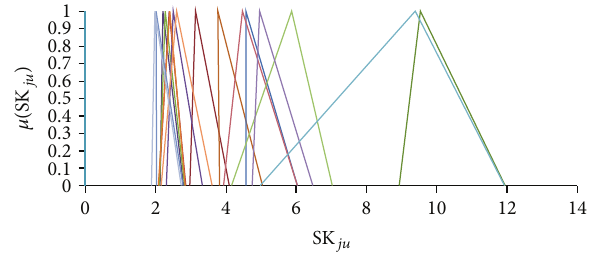
Figure 7: The fuzzy slacks obtained by using Wang et al.’s